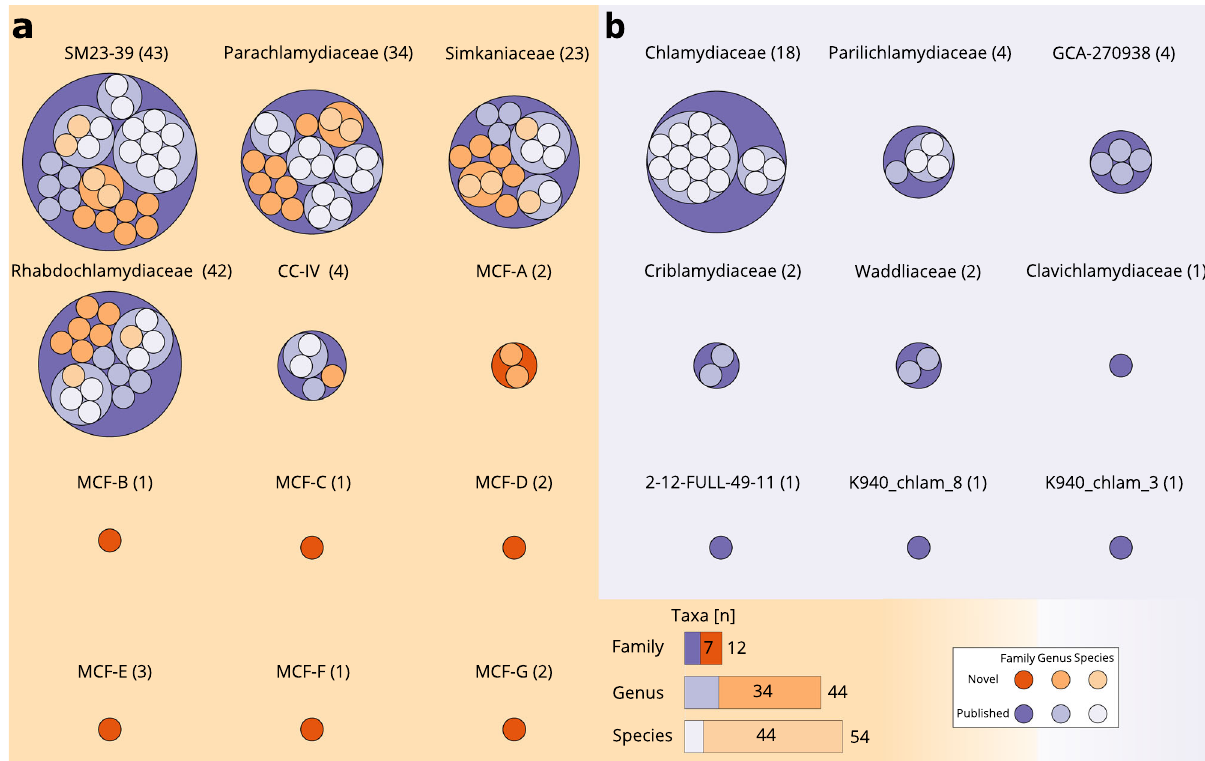
Fig. 2 MAGs from the GEM dataset broadly populate the taxonomy of the Chlamydiae at family-, genus-, and species rank. MAGs from the GEM catalog signi fi cantly extend known chlamydial taxa, including 7 additional families, 34 genera, and 44 species, highlighting the taxonomic heterogeneity of the phylum. Packed circles represent chlamydiae taxonomic ranks and their higher level taxonomic structure. From the outermost to the innermost circle the family, genus, and species ranks are depicted. Violet indicates lineages with previously known genome representatives (family, genus, species rank in dark, medium, and light violet, respectively), while added lineages are shown in orange (family, genus, species in dark, medium, and light orange, respectively). The number in brackets next to the family names indicates the number of genome sequences available. a Known and previously undescribed chlamydial families containing MAGs from the GEM catalog. Bar charts represent the number of families, genera, and species recruited in this study. b Families without genome sequences from this